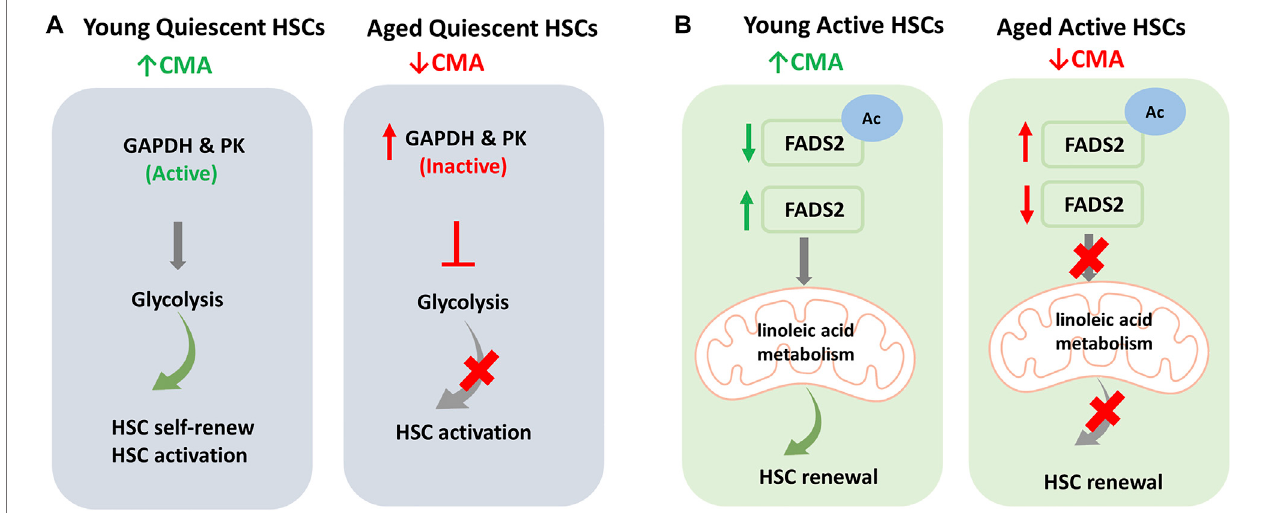
FIGURE 6 | Regulation of Haematopoietic stem cells (HSCs) by Chaperone-Mediated Autophagy (CMA): (A) Young quiescent HSCs are characterized by high levels of basal CMA and, thanks to the high activity of glyceraldehyde-3-phosphate dehydrogenase (GAPDH) and pyruvate kinase (PK), have a glycolysis-based metabolismthatallowscellself-renewalandactivation.InagedquiescentHSCs,reducedCMAactivityincreasesCMAsubstrateslikeinactiveGAPDHandPKenzymes. This reduces the glycolytic process and consequently limits HSC activation. (B) In active HSCs, fatty acids metabolism plays a key role. In young active HSCs the acetylatedinactivefattyaciddesaturase2(FADS2)isremovedbyCMAandactiveFADS2allowslinoleicacidmetabolismandHSCself-renewal.InagedactiveHSCs,the reduced levels of CMA results in increase in acetylated inactive FADS2 that inhibits linoleic acid metabolism. This consequently limits renewal capacity of HSCs.